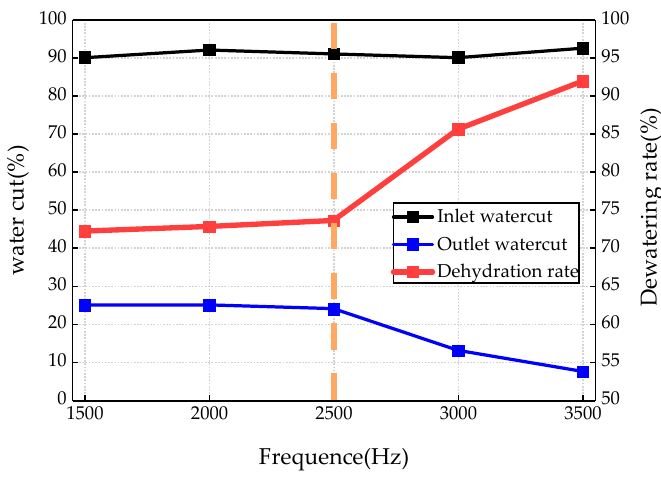
Figure 9. The water cut of oil and the dehydration rate in different pulse frequencies.